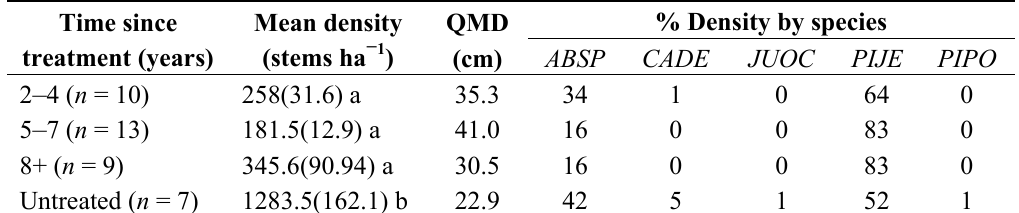
Table 3. Eastside pine mean stand density (standard error), quadratic mean diameter (QMD), and mean contribution of each tree species to total density for each time-since-treatment category. Different letters indicate significant difference in means between groups (Tukey’s HSD multiple comparison test, p < 0.05). Calculations include all trees with diameter at